Question: Write a single sentence explaining what this figure depicts.
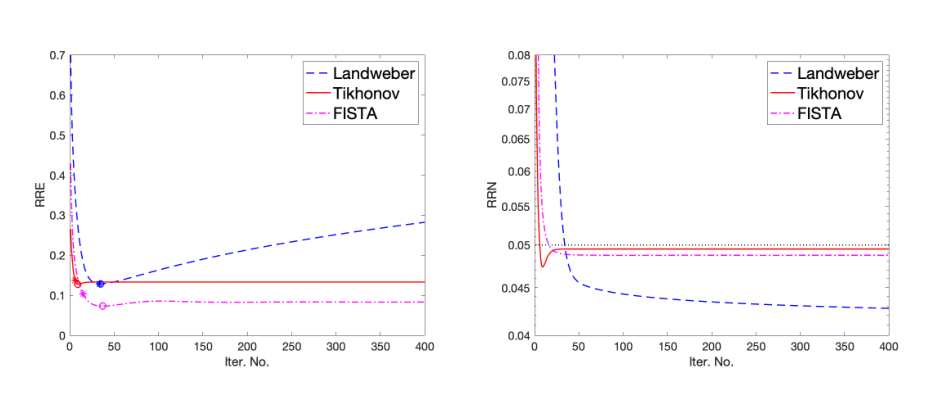
Answer: RRE and RRN plots for Example #1 with a = 0.05 and c = 0. The black dashed line in the RRN plot (right) indicates where the methods would terminate according to the DP. Colored stars and circles in the RRE plot (left) indicate termination according to the DP and the smallest RRE achieved in the allotted iterations, respectively.